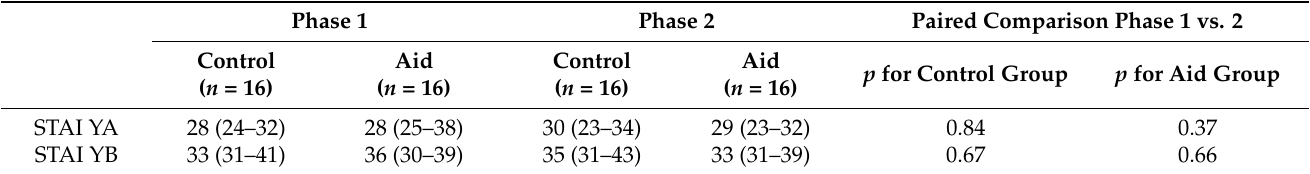
Table 3. Anxiety evaluation in residents using the State-Trait Anxiety Inventory